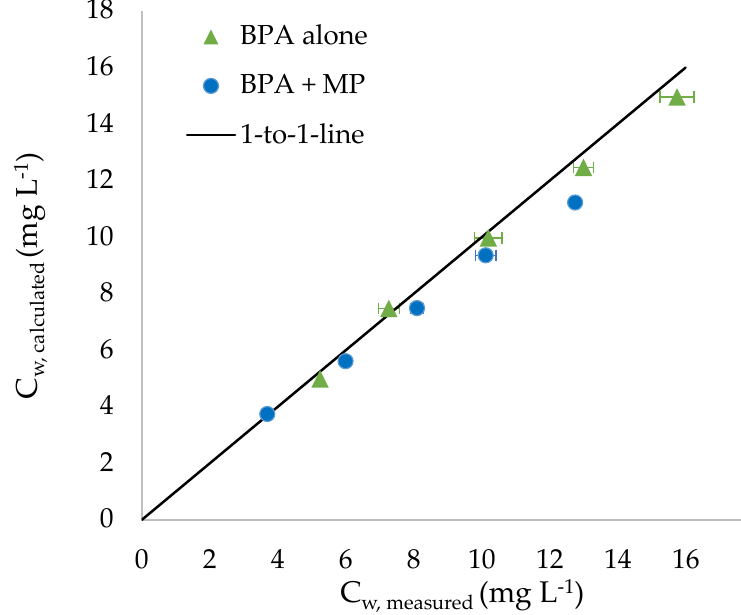
Figure 2. Relationship between measured (means ± SD, n = 5) and calculated concentrations of bisphenol A (BPA) in water for treatments with BPA alone and BPA combined with microplastics (MP) (treatment BPA + MP).